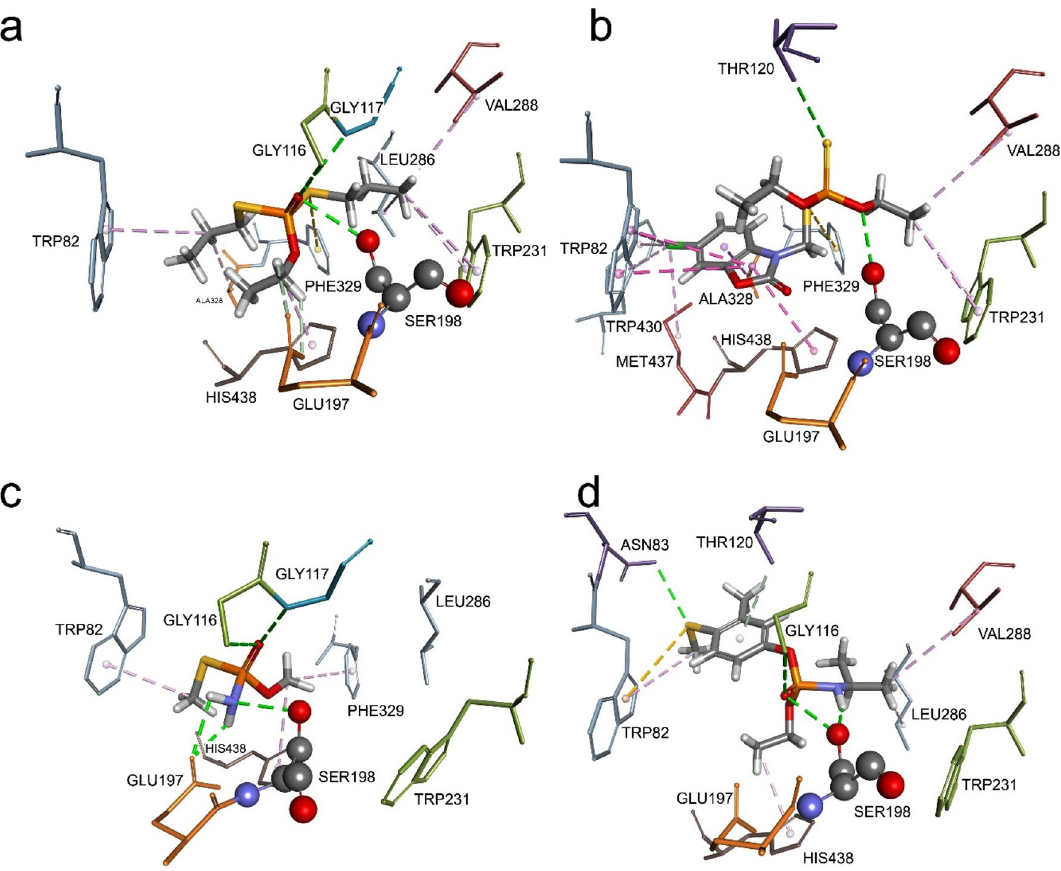
Figure 4. Model of Michaelis–Menten type complex of organophosphorus pesticides: ethoprophos ( a ), phosalone ( b ), methamidophos ( c ), and fenamiphos ( d ) within the active site of hBChE (PDB code: 2PM8 29 ). Poses were selected based on criteria that leaving group of pesticide is oriented opposite from oxygen (Oγ) of catalytic serine (Ser198). Pesticide interactions are represented as dashed lines: hydrophobic (purple), hydrogen bonds (green) and electrostatic (orange).